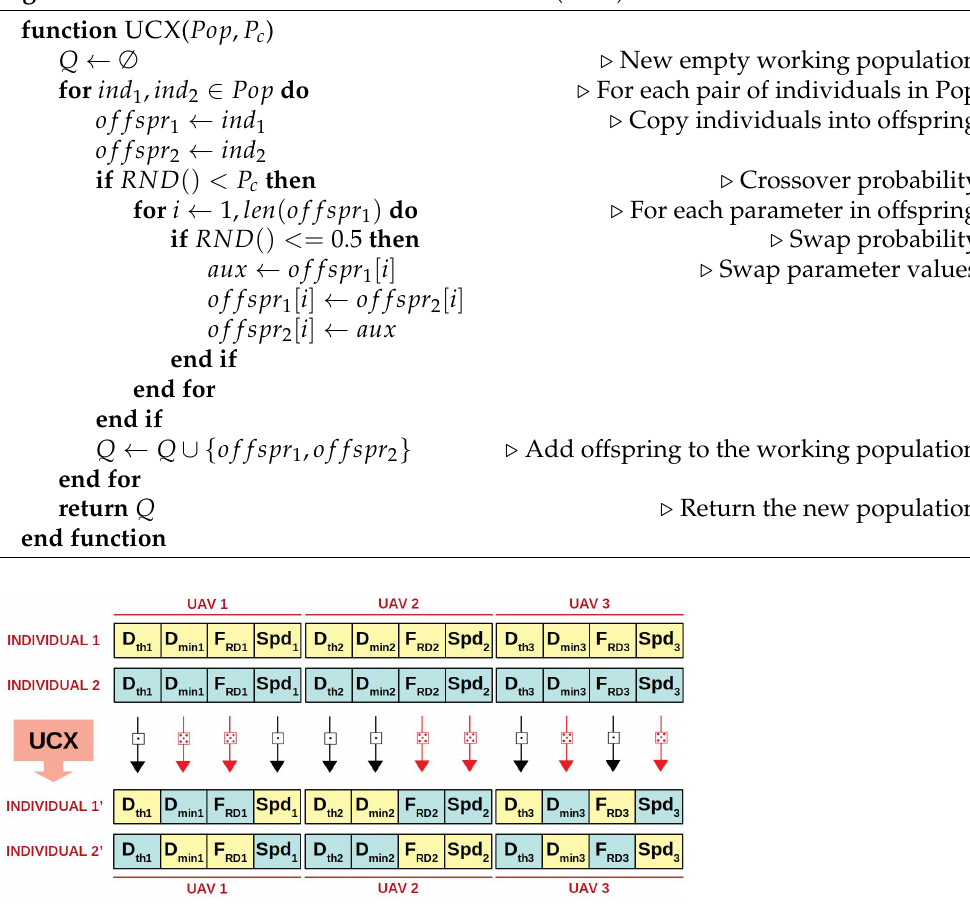
Figure 4. Uniform crossover